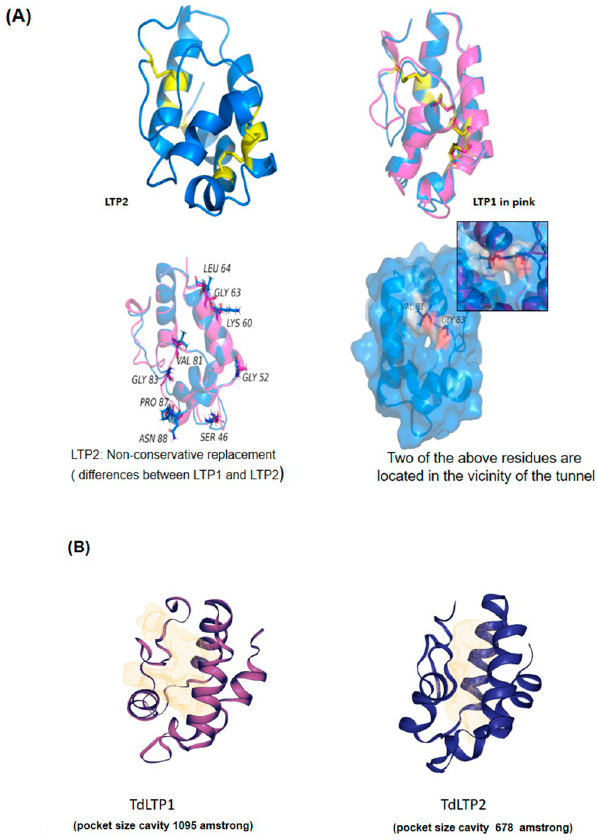
Fig 2. 3D structural modeling of TdLTP2 with the reference model of TdLTP1. (A) Comparison of the primary and tertiary structures of TdLTP2 and TdLTP1 reveals that nsLTP subfamilies display 71% of sequence homology and share a similar α -helical fold that is stabilized by four disulfide bonds (highlighted in yellow). (B) Pocket size cavity of TdLTPs calculated by DogSite method implemented in the Proteins Plus server.